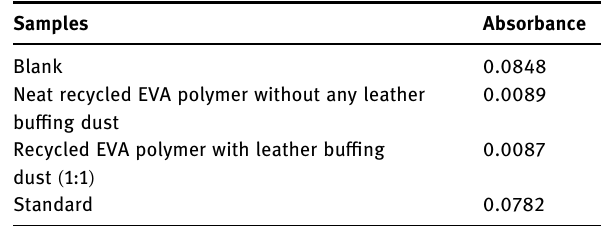
Table 3: Absorbance values obtained with phosphate bu ff er testing